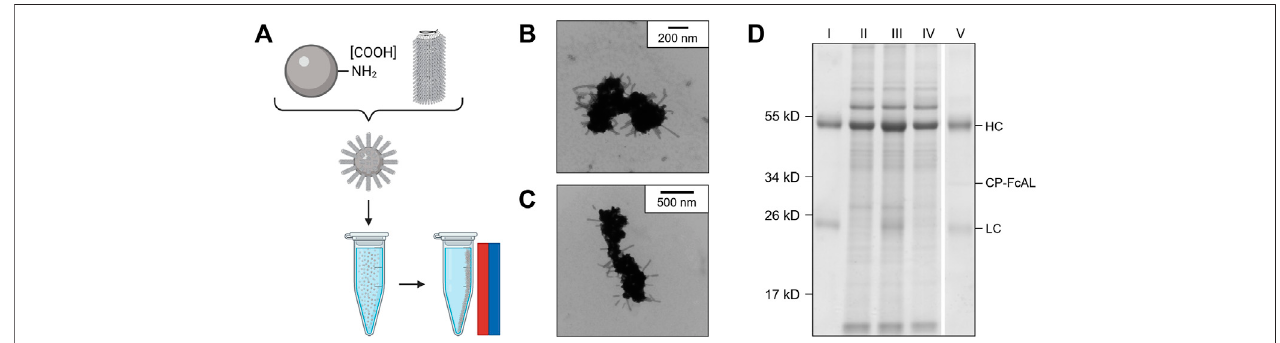
FIGURE 5 | Production of plant virus-based immunosorbent nanoparticles coupled with magnetic particles (VIN-MPs). (A) An illustrative depiction of VIN-MPs. (B,C) NegativestaintransmissionelectronmicroscopeimagesofVIN-MPsgeneratedusingamine-terminatedmagneticparticlesand5%glutaraldehyde(VIN-MP-NGs). (D) Reducing condition SDS-PAGE of human immunoglobulin G (hIgG) bind-and-elute using VIN-MP-NGs and magnetic separation. Samples of VIN-MPs are not included in the gel due to the incompatibility of the MPs with SDS-PAGE. Gels are marked with band heights corresponding to VIN coat protein Fc-af fi nity ligand fusion (CP-FcAL) and hIgG heavy chain (HC) and light chain (LC) constituents. Lane de fi nitions: I — initial hIgG added; II — N. benthamiana plant extract; III — hIgG spiked into N. benthamiana plant extract; IV — non-bound supernatant after magnetic separation with VIN-MPs; V — hIgG elution from